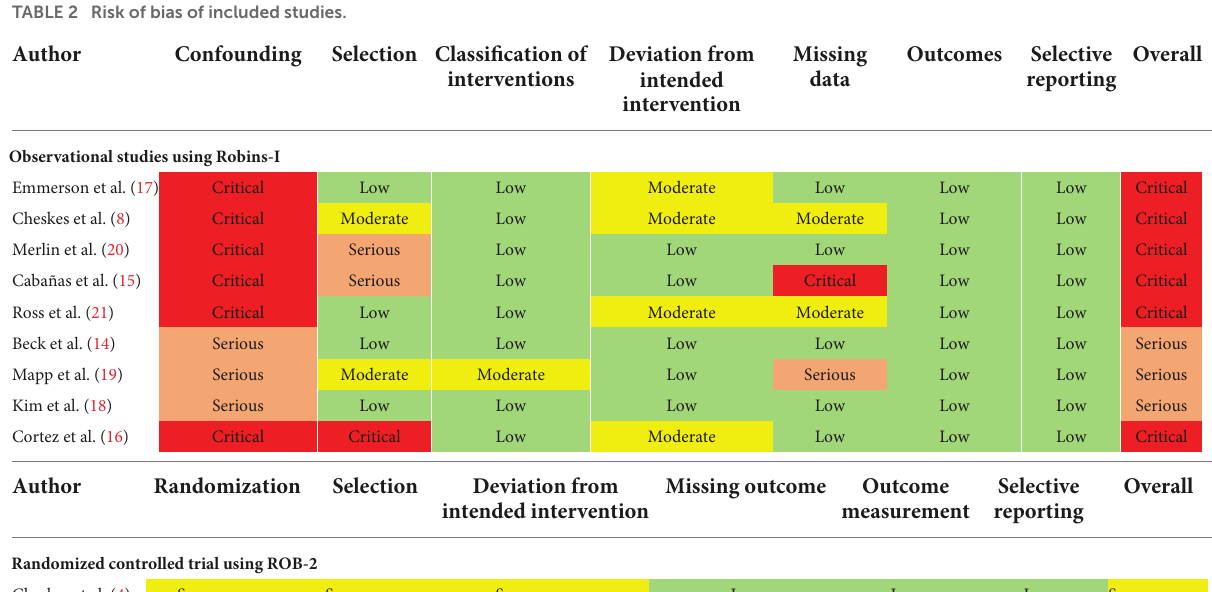
TABLE 2 Risk of bias of included